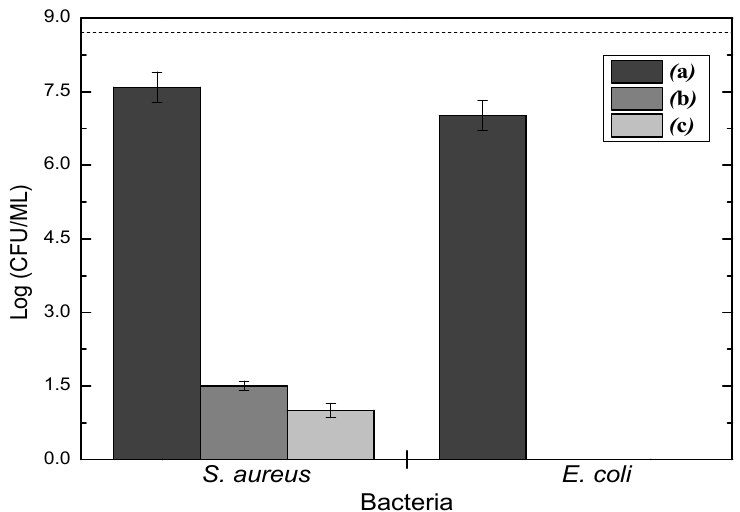
Figure 8. The concentration of S. aureus and E. coli on stainless-steel slides as-received ( a ), immersed for 45 min in liquid carvacrol ( b ), and coated with plasma deposited carvacrol for 45 min ( c ). The dotted line indicates the concentration of bacteria in the initial inoculum.